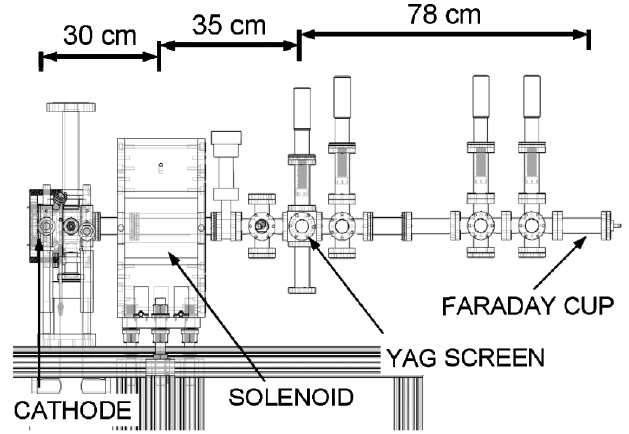
FIG. 2. (Color) Picture of the Cu backflange. At the center is clearly visible the Mg film. FIG. 3. Schematics of the PEGASUS rf-gun beam